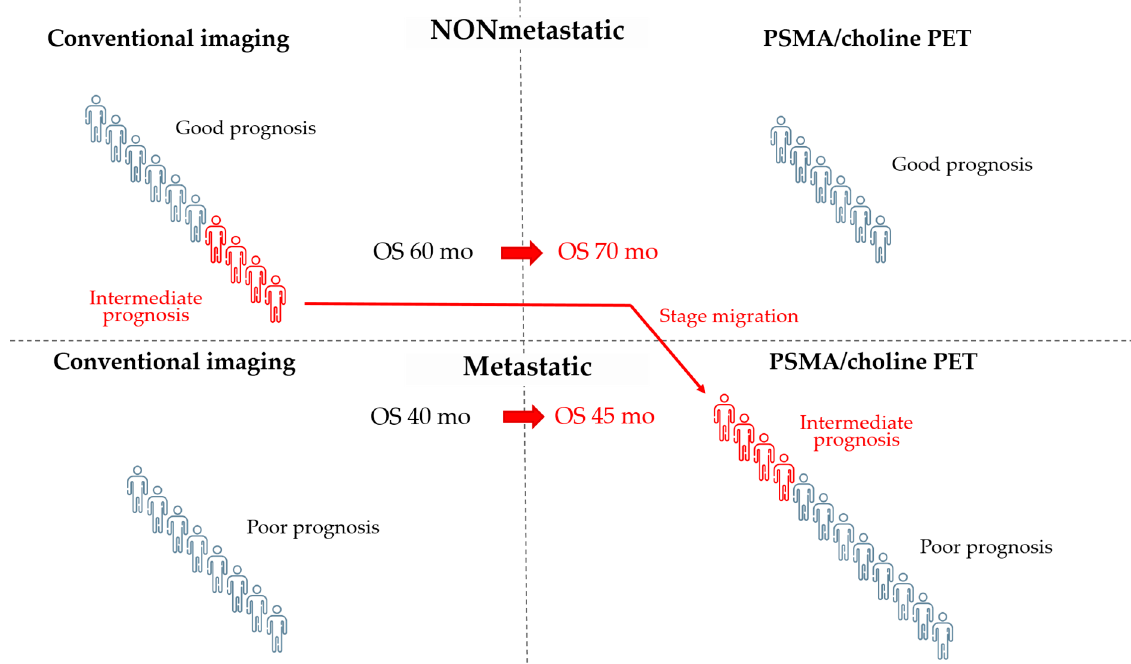
Figure 1. The use of PSMA or choline PET can cause stage migration and the Will Rogers phenomenon . In this example, patients who are metastatic by PET but not by conventional imaging (CIM) show an intermediate prognosis, which is better than that of metastatic patients and worse than that of nonmetastatic patients by CIM. Staging by PET moves these patients with intermediate prognosis to the group of patients with metastatic disease and poor prognosis. The final result is an improvement in the prognosis of both nonmetastatic and metastatic groups of patients by CIM without changing the individual prognosis of patients. It is unknown whether modifying the therapeutic approach in the subgroup of patients with intermediate prognosis could lead to an improvement in their outcome. OS: overall survival.